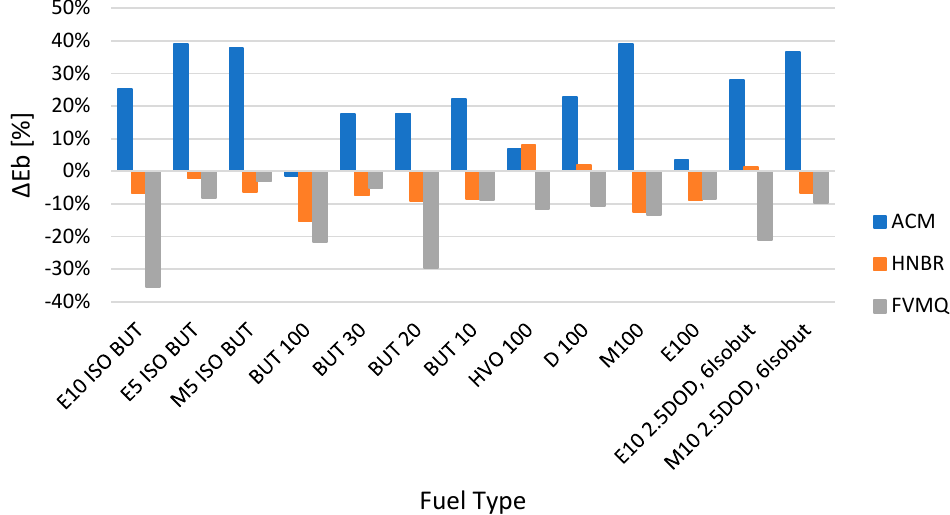
Figure 5. Change in elongation ∆ Eb for different elastomer O-rings and fuels after exposure for a time interval of 2998 h.